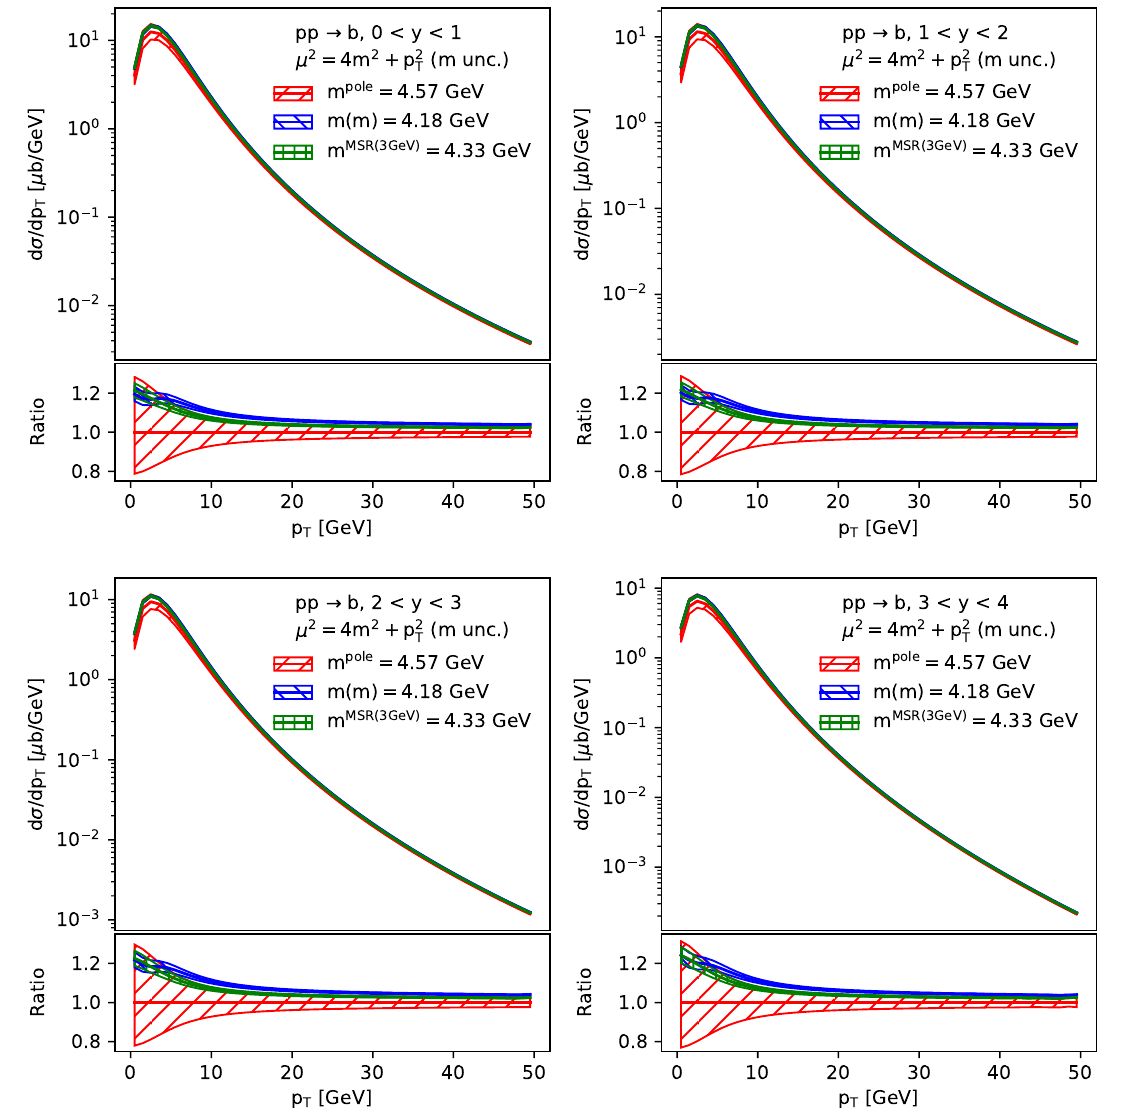
Figure 10 . Same as figure 8 for bottom production with variations of the mass values in the different schemes as m pole = 4 . 57 ± 0 . 25 GeV, m b ( m b ) = 4 . 18 ± 0 . 03 GeV and m MSR b